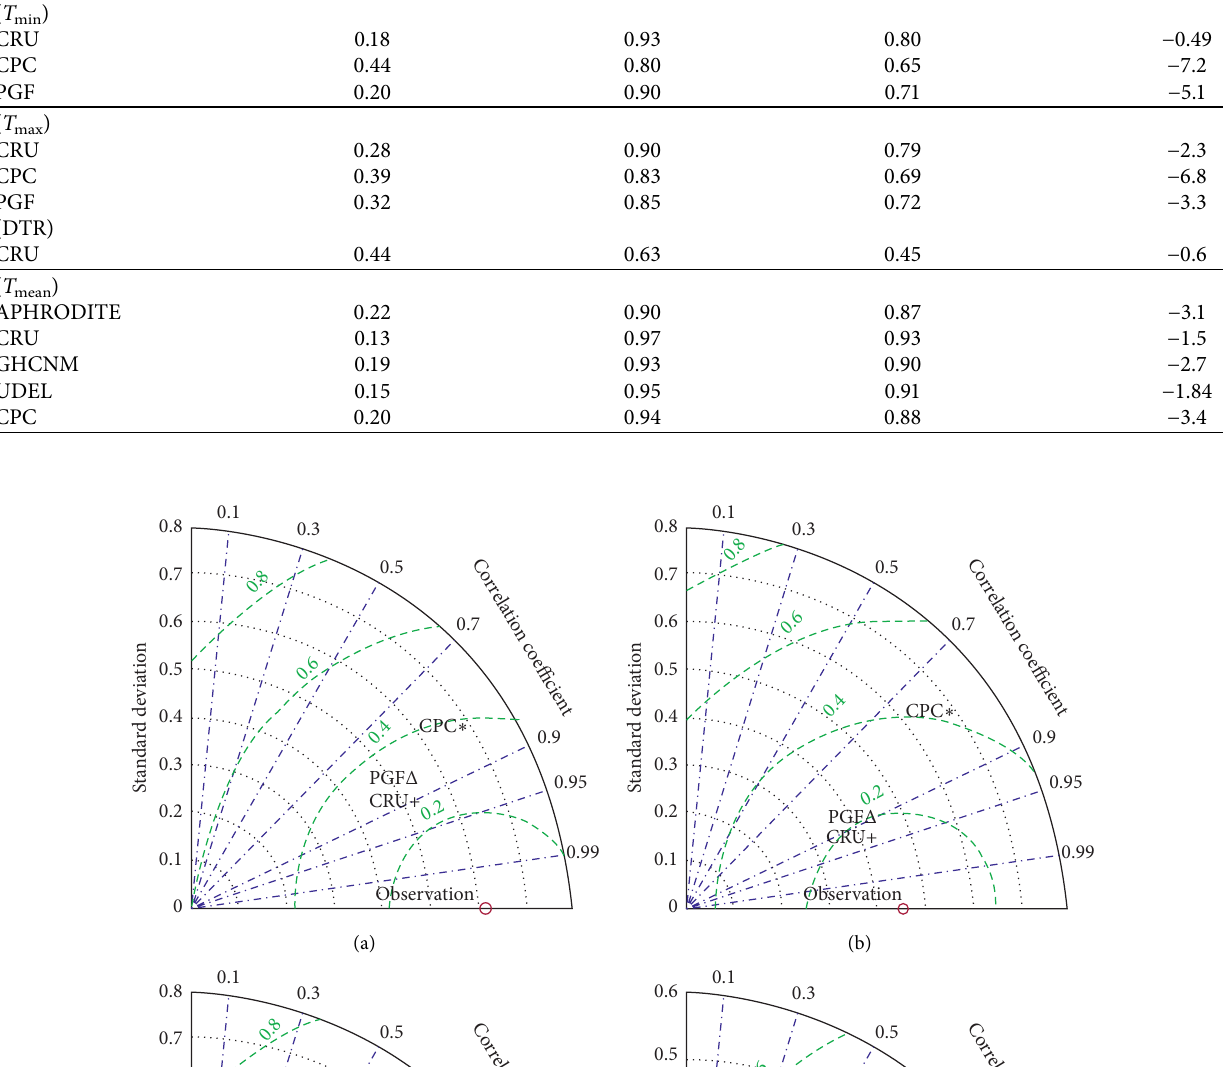
max , (b) T min , (c) DTR, and (d) T mean